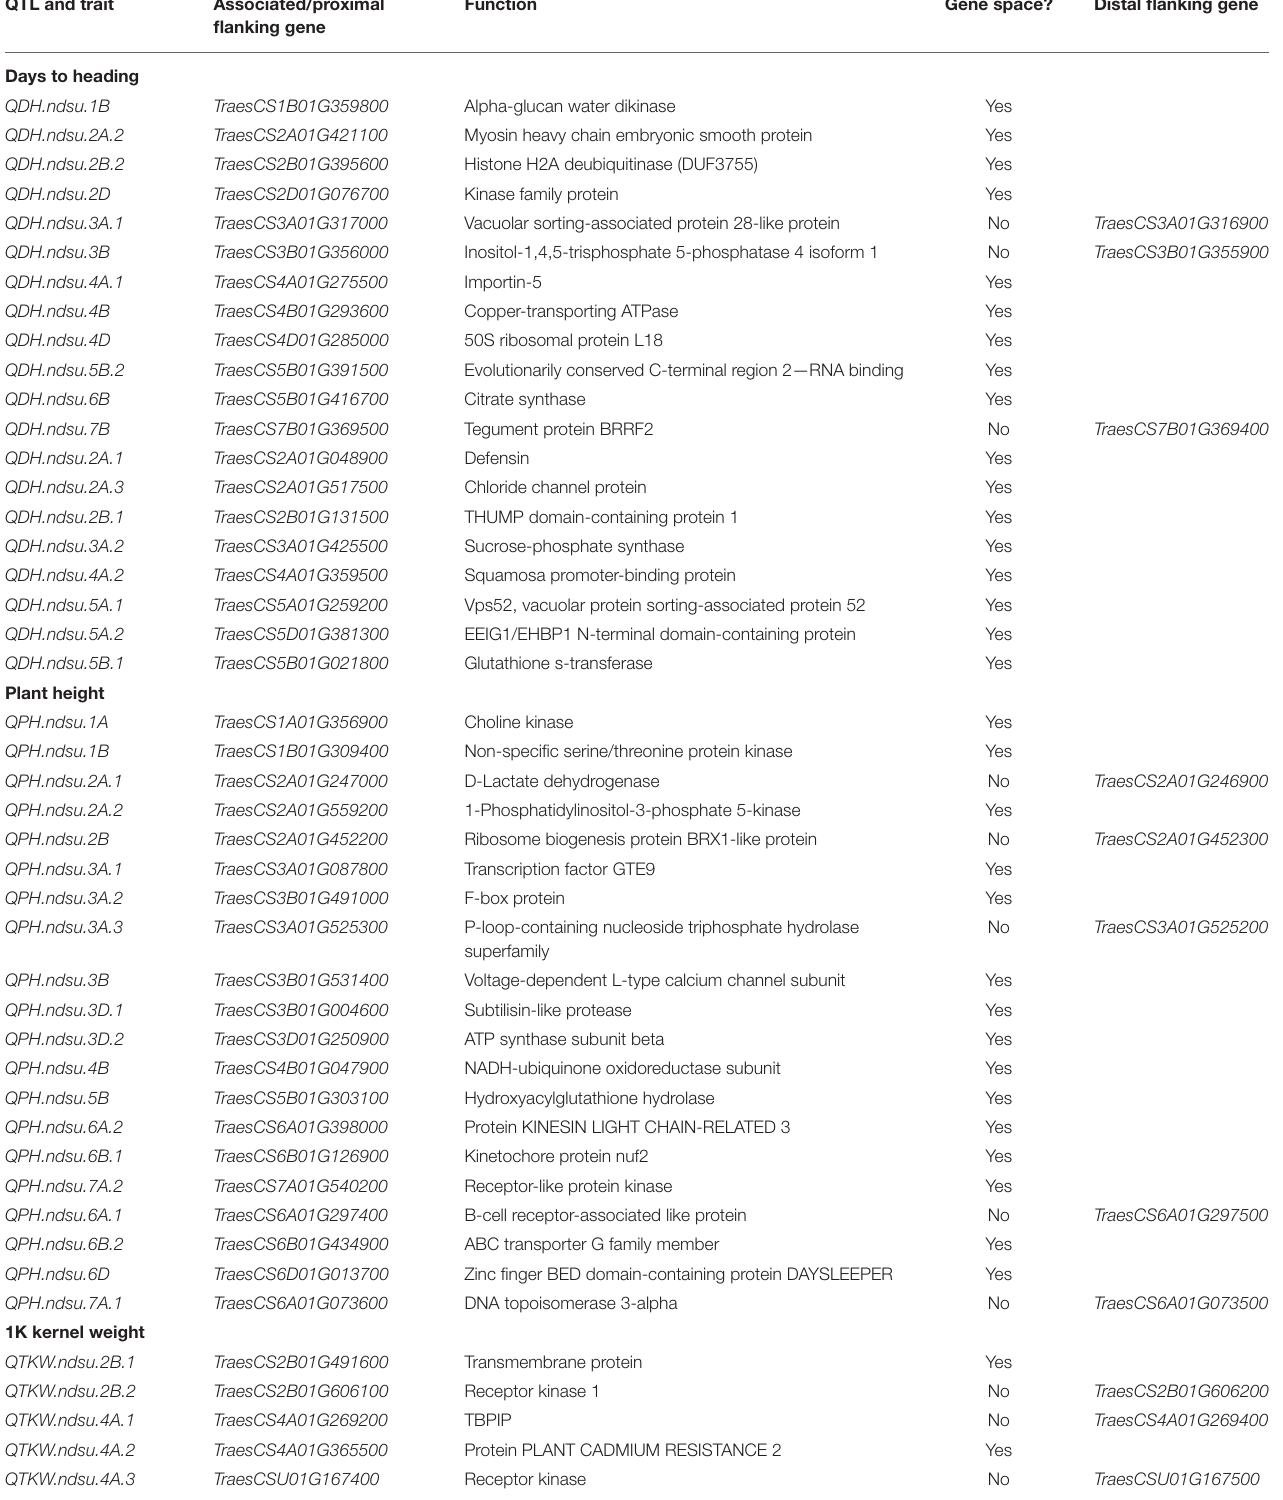
TABLE 5 | List of candidate genes associated with QTL identified in this